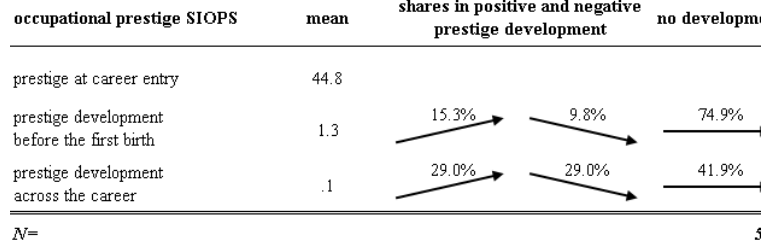
Note: prestige at career entry reported in absolute values, not